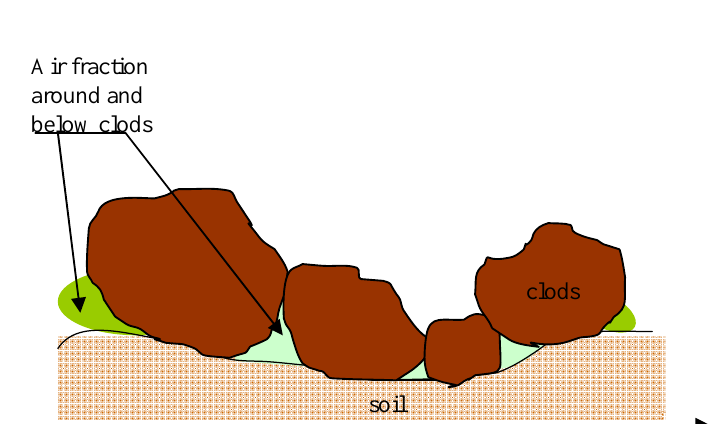
Figure 4. Clod illustration, showing soil and air